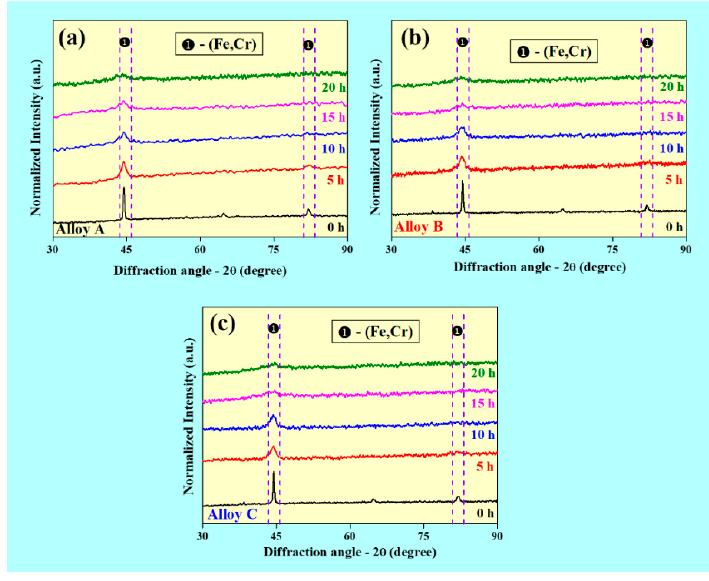
Figure 1. X-ray diffraction (XRD) patterns of the mechanically alloyed powders: ( a ) Alloy A, ( b ) Alloy B, and ( c ) Alloy C as a function of milling time.